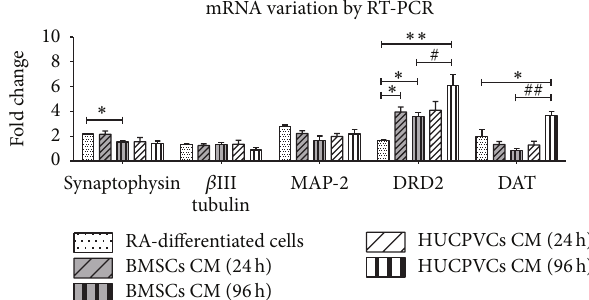
Figure 6: Variation of neuronal markers seven days after incubation with BMSCs and HUCPVCs CM. Levels of mRNA for different neuronal markers were quantified by quantitative real-time RT- PCR and normalized to both undifferentiated/proliferative cells (reference level: 1) and HBMS housekeeping gene. Quantification of neuronal markers expression revealed that BMSCs CM 24 h and 96 h displayed a significant increase in the SH-SY5Y cells expression of DRD2 gene when compared to RA-differentiated cells ( 𝑃 < 0.05 ). However, BMSCs CM 96 h simultaneously induced a decrease in synaptophysin in comparison with RA-differentiated cells ( 𝑃 < 0.05 ). On the other hand, for all the neuronal markers studied, no statistically significant differences were found between HUCPVCs CM 24 h and RA groups ( 𝑃 > 0.05 ). Yet, HUCPVCs CM 96h significantly elevated mRNA levels of DRD2 and DAT genes when compared with both BMSCs 96h ( 𝑃 < 0.05 ; 𝑃 < 0.01 ) and RA-differentiated cells ( 𝑃 < 0.01 ; 𝑃 < 0.05 ). The later results suggest that HUCPVCs CM 96h is inducing SH-SY5Y cells towards the DAergic phenotype. In addition, differences between BMSCs and HUCPVCs from the same time point indicate that different tissue derived MSCs secretome have distinct effects in SH- SY5Y cells differentiation with respect to neuronal phenotype. For all the other neuronal markers studied, no significant statistical differences were observed between all CM tested conditions and RA-differentiated cells ( 𝑃 > 0.05 ), which strongly indicates that the CM from BMSCs and HUCPVCs are capable of inducing SH-SY5Y cells neuronal differentiation. Moreover, the different expression pattern of neuronal markers exhibited by SH-SY5Y cells among CM time points of collection indicates that the effects mediated by MSCs secretome in SH-SY5Y cells differentiation is related with the temporal profile of CM collection (values are shown as mean ± SEM, 𝑛 = 3 ). Symbols correspondence to statistical signification: (1) ∗ refers to comparisons between RA-differentiated cells and MSCs CM and (2) # regards the correlation between MSCs CM from the same time point ( ∗∗/ ## 𝑃 < 0.01 , ∗/ # 𝑃 < 0.05